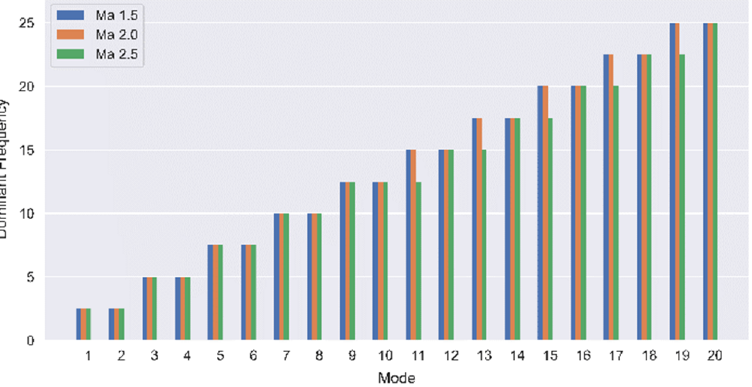
Figure 15. Time coefficients of the first 20 modes in the SWBLI region with ( a ) Ma = 1.5, ( b ) Ma = 2.0, ( c ) Ma = 2.5.